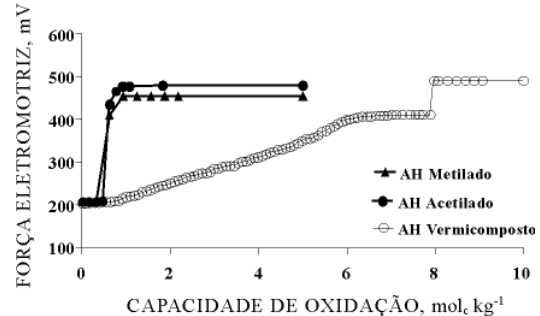
Figura 4. Titulações redox de 6,25 mg de ácido húmico e de 6,25 mg de seus derivados obtidos por metilação e acetilação, suspensos em 125 mL de KCl 0,05 mol L -1 e solução-tampão fosfato 0,05 mol L -1 , a pH